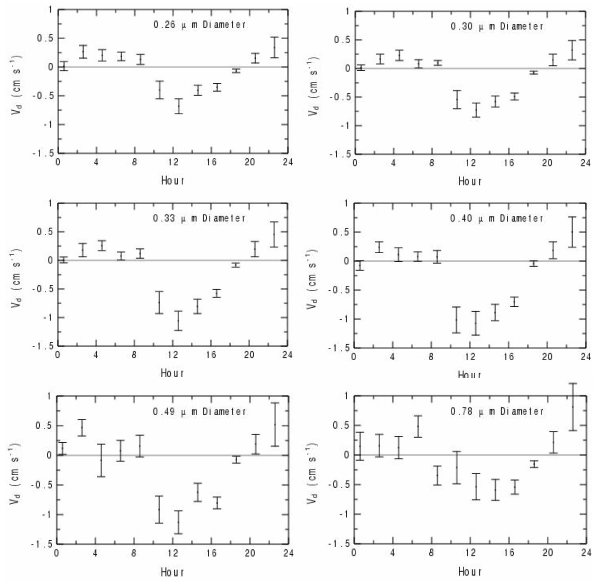
Fig. 1. Diurnal variation of aerosol deposition velocity for six parti- cle diameters as measured during BEARPEX 2007 (negative V d is downward). No corrections have been applied to these data. Bars indicate ± one data standard error for values recorded during that two hour period. Times are given as